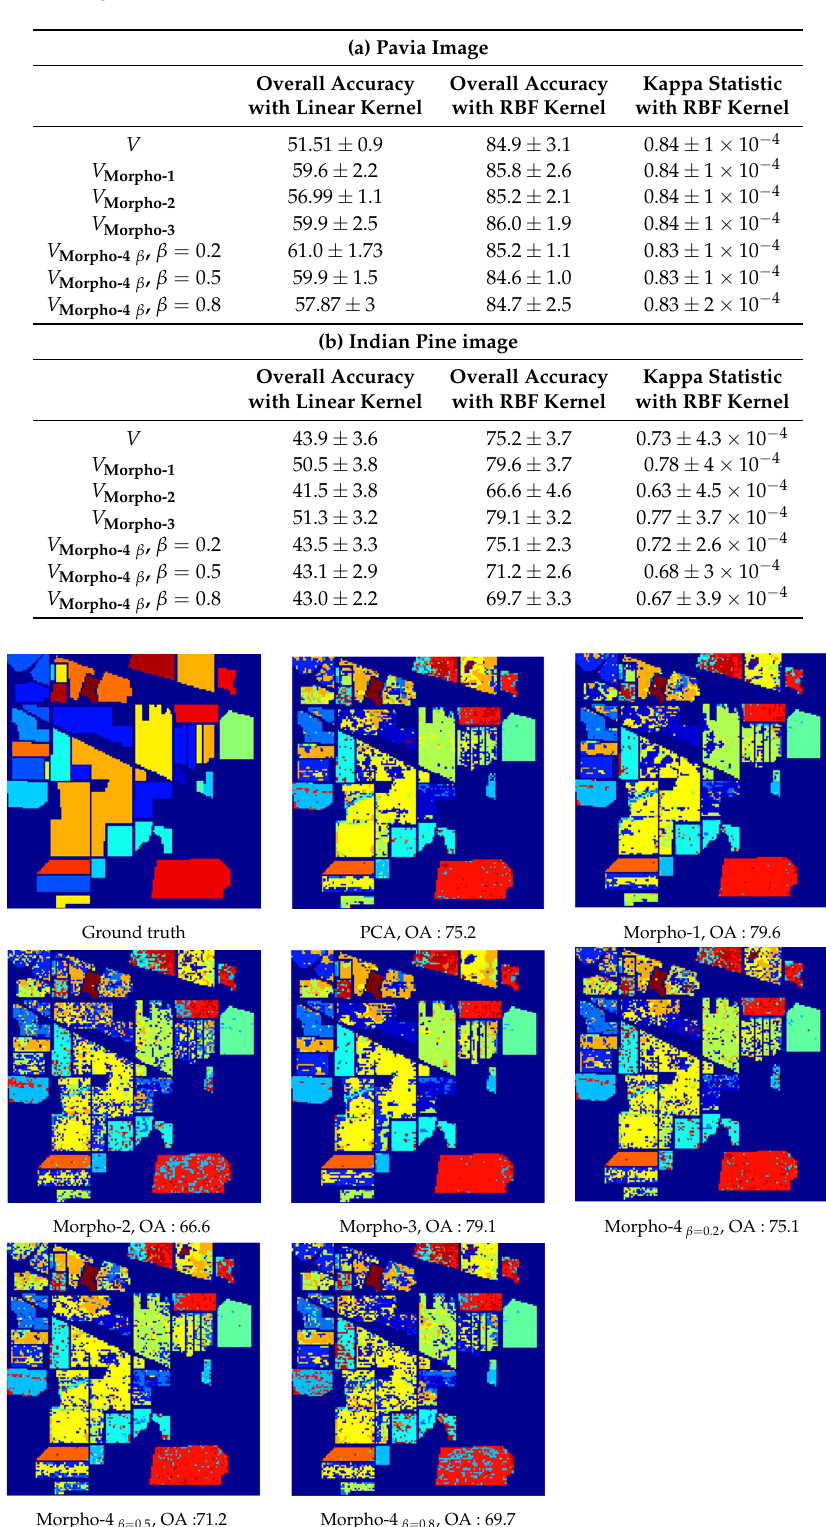
Table 3. Comparison of hyperspectral supervised classification on PCA and MorphPCA spaces using least square SVM algorithm and different kernels: ( a ) Pavia hyperspectral image; ( b ) Indian Pines hyperspectral image.